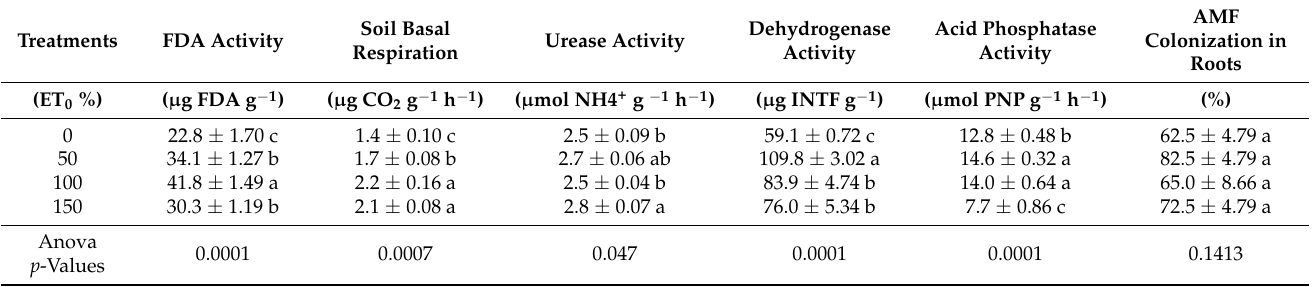
Table 3. Soil microbiological properties and enzyme activity in response to water replenishment.